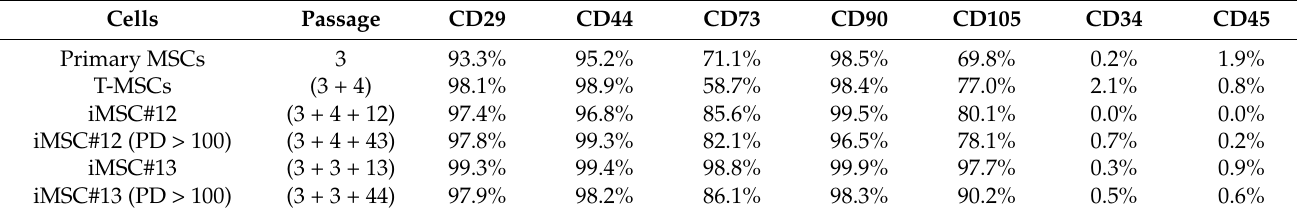
Table 1. Phenotypical analysis to determine the mesenchymal and hematopoietic surface markers ’ expression pattern in primary MSCs, T-MSCs and iMSCs at different (early and late) passages. Pas- sage is represented as the number of subcultures as (1) primary MSCs, (2) T-MSCs and (3) iMSCs. Data from primary MSC#13 and T-MSC#13 could not be obtained because of limited cell number, and therefore only primary MSC#12 and T-MSC#12 are shown.